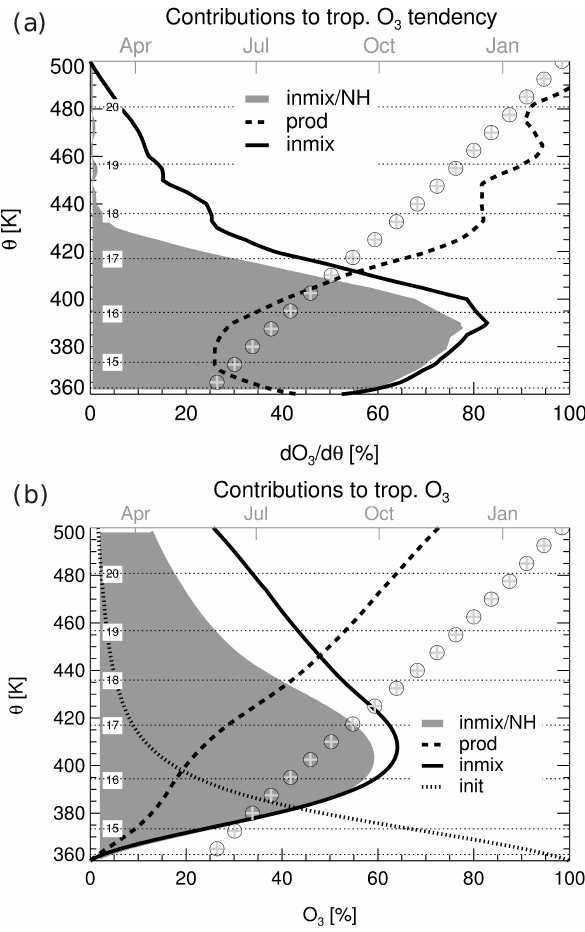
Fig. 4. (a) Relative contributions [%] to the change in ozone (i.e., ozone tendency) along an ascending tropical trajectory in the 1-D model. The parcel reaches the level of 500K on 15 February and hence ascends through the TTL during the previous summer (time along the parcel trajectory is indicated by the gray “+” symbols, with scale shown in the upper x-axis). The different lines show: photochemical production along the ascent (black dashed), total in- mixing (black solid), in-mixing from the NH only (gray shading). The tendency terms are expressed as given on the right-hand side of Eq. (4), and shown relative to the total tendency at each level. (b) Same as (a) , but for the contributions to mean tropical ozone. The dotted line labeled “init” shows the contribution of the initial- ization concentration in the 1-D model (i.e., SHADOZ ozone at 360K). This term is necessary for the lines in (b) to sum 100%. Log-pressure annual mean altitudes are indicated by the horizontal dotted lines and labeled in